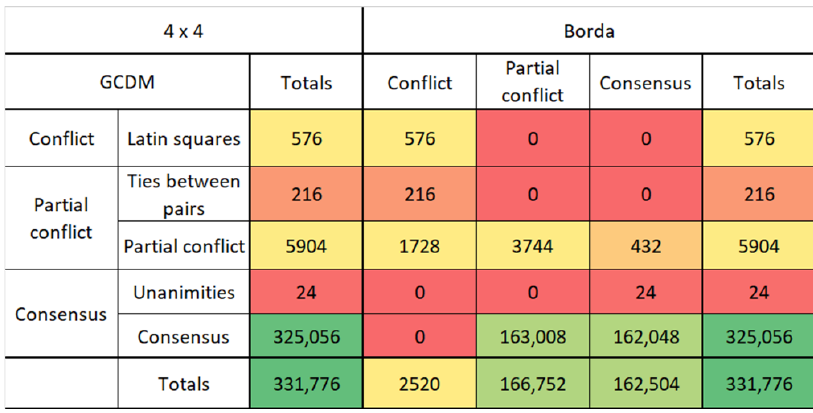
Figure 23. GCDM transformation of Borda conflicts and consensus for 4 × 4 matrices.